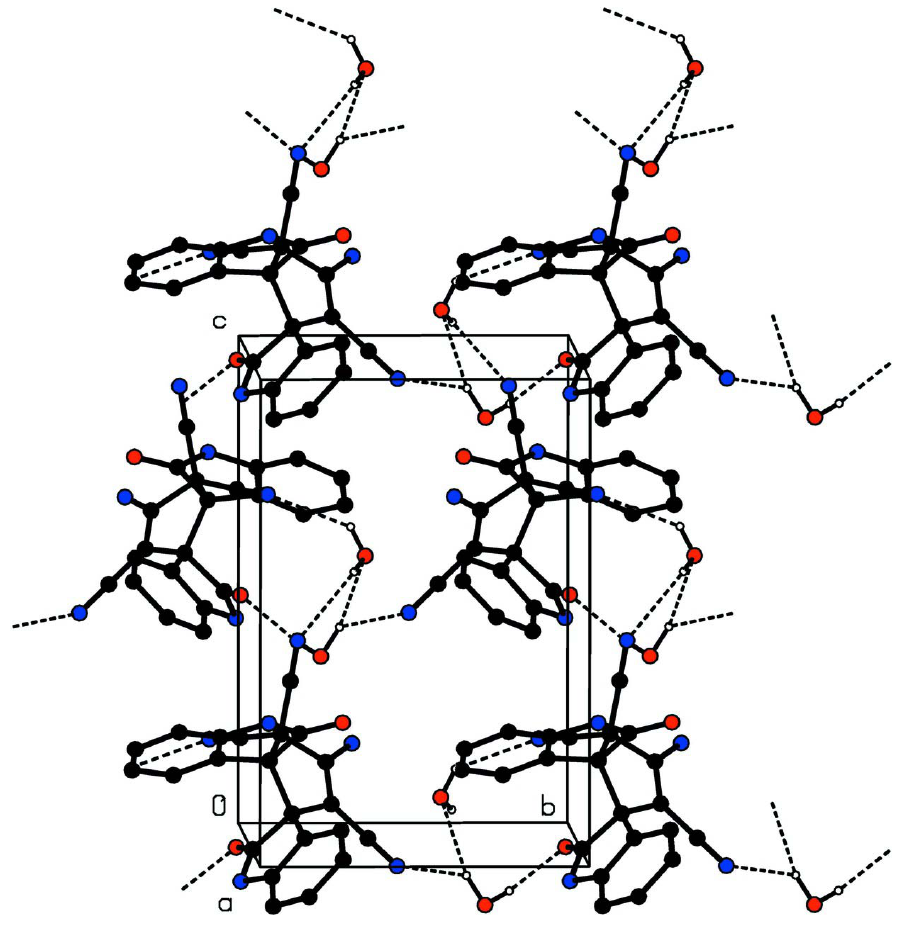
Figure 2 The molecular packing viewed down the a axis, showing O—H···N and O—H···O intermolecular